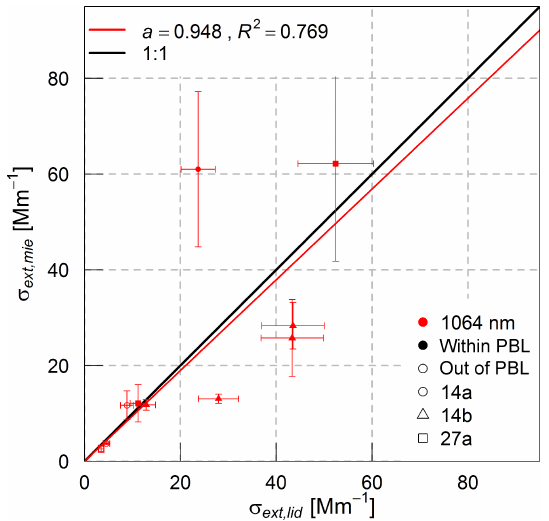
Figure 16. Scatterplot of particle light extinction coefficient de- rived with Mie calculations ( σ ext, mie ) and lidar-based ( σ ext, lid ) for all horizontal legs during the investigated days for λ = 1064nm. σ ext, lid derived with a lidar ratio (LR) of 30sr. The error bars rep- resent the assumed 15% error for the lidar measurements and 3 times the standard deviation of the mean of the result of the Mie calculations. Lines and symbols as in Figs. 14 and